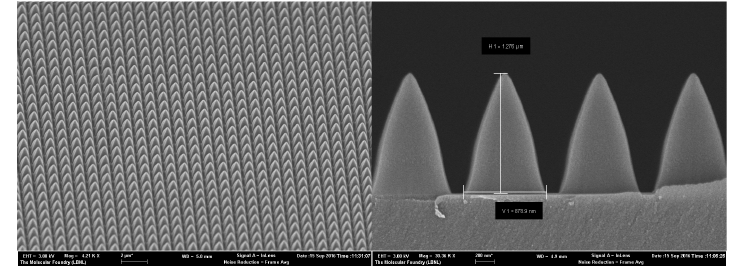
Figure 16. SEM image of the silicon mask for pyramidal pattern production